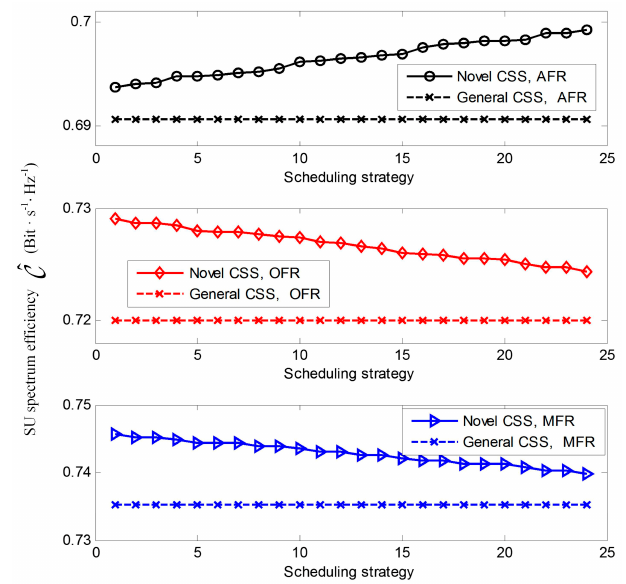
Figure 7. Spectral efficiency ˆ C versus scheduling strategy for the novel CSS scheme under fusion rules of AFR (and fusion rule), OFR (or fusion rule) and MFR (majority fusion rule), respectively.